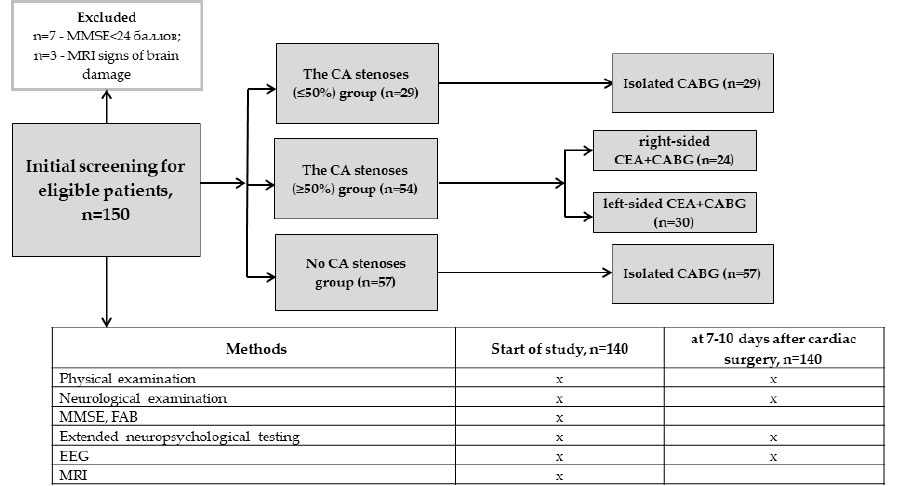
Figure 1. Overview of the study design.